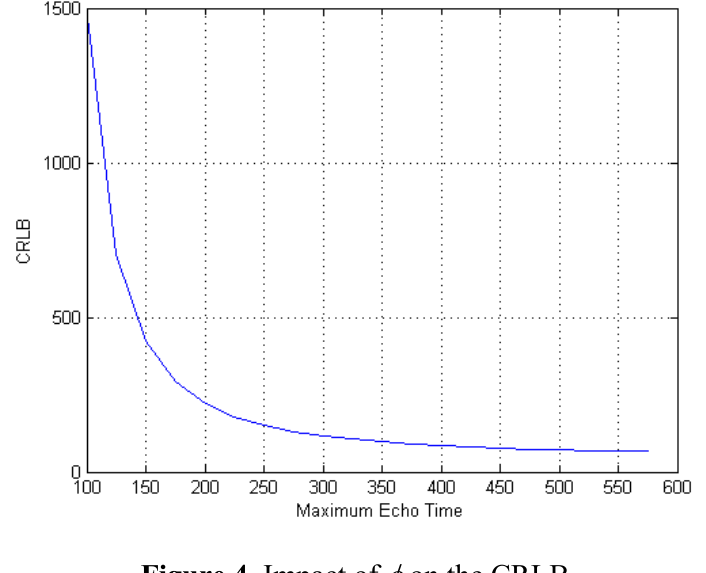
Figure 4 . Impact of  on the